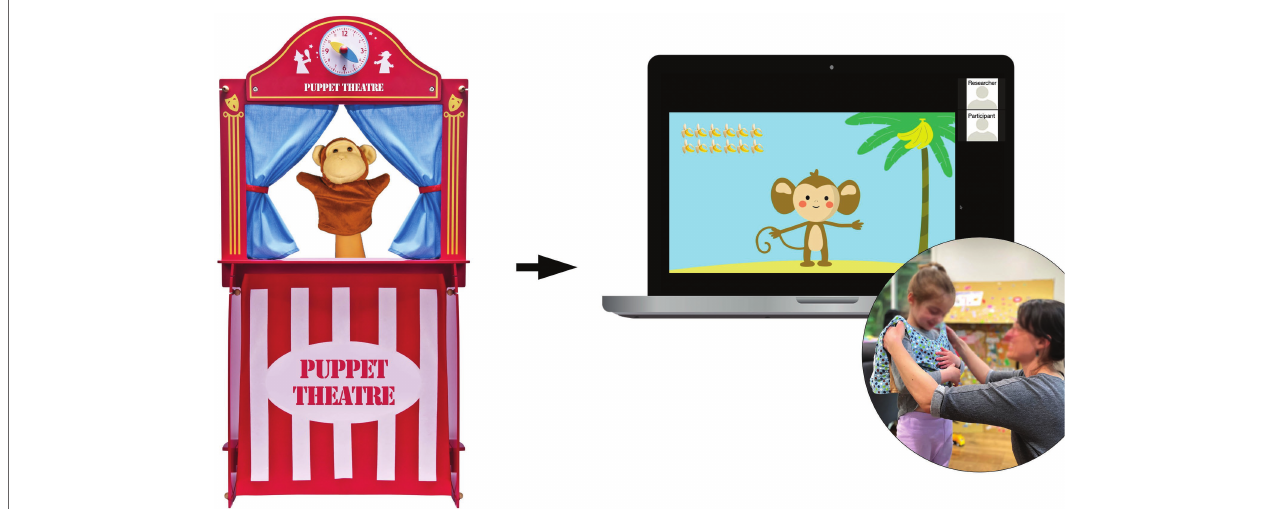
FIGURE 1 | Visualization of the Imitation Study. Digital cartoon animation adapted from in-lab puppet theater setup, used to deliver auditory stimuli remotely via Zoom during the imitation task. Speech data collected via LENA vests and recorders worn by child participants (Cai and Kuhl, in prep).